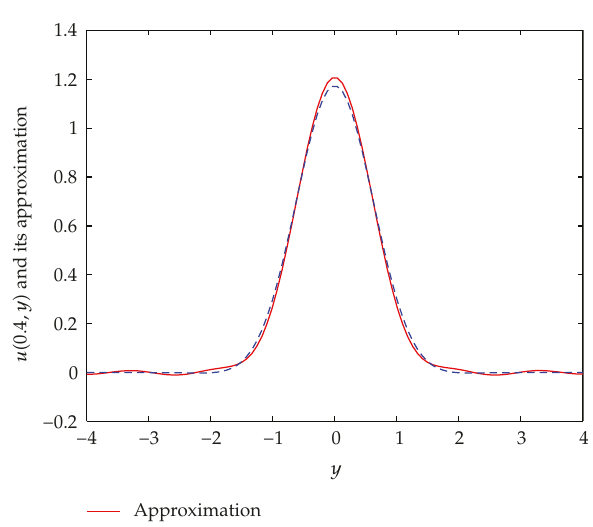
Figure 3: x (cid:2) 0 . 4 , δ (cid:2) 1 ∗ 10 − 2 , ξ